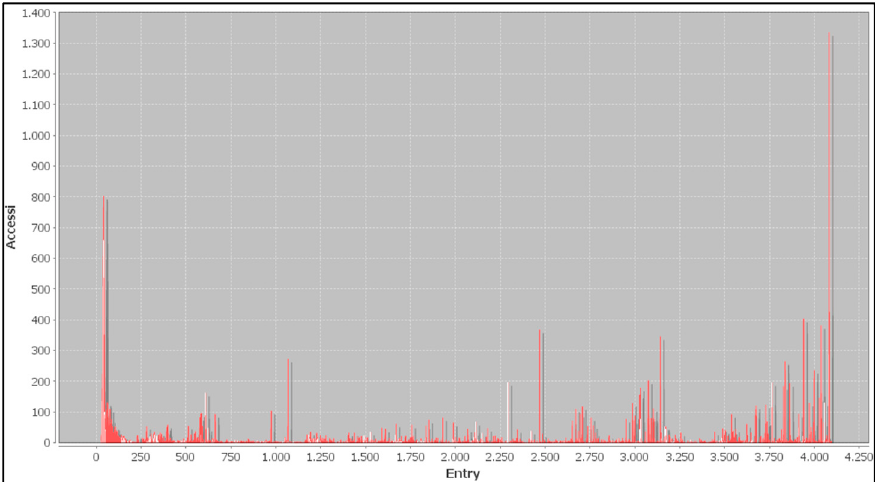
Figure 7. Graphical representation of the number of access (on the y -axis) to a specific index of the dictionary (on the x -axis) during the compression phase.